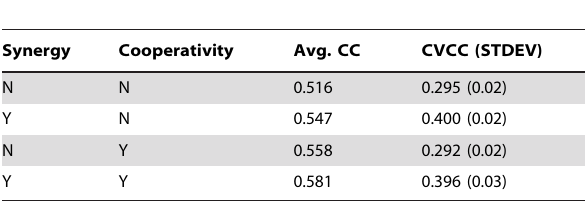
Table 3. Effect of transcriptional synergy on model